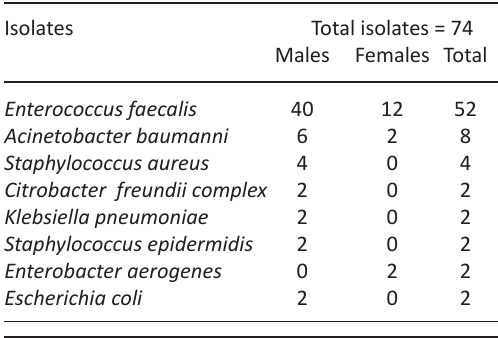
Table 2. Distribution of E . faecalis and its associated organisms among males & females Isolates Total isolates =